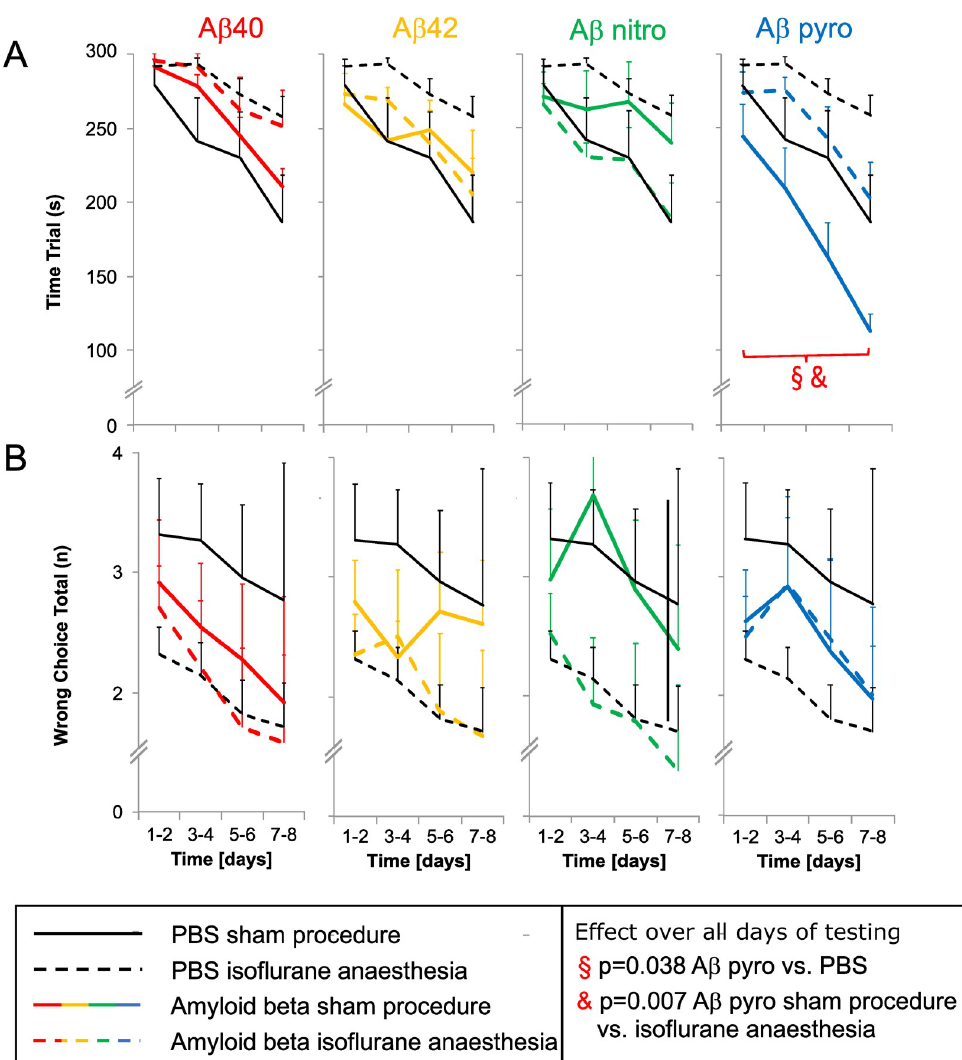
Fig 1. Neurocognitive function after anaesthesia in mice injected with different A β subspecies compared to control. A: Time Trial (overall cognitive performance), B: Wrong choices total (declarative memory); mean of all tests on two days and standard error